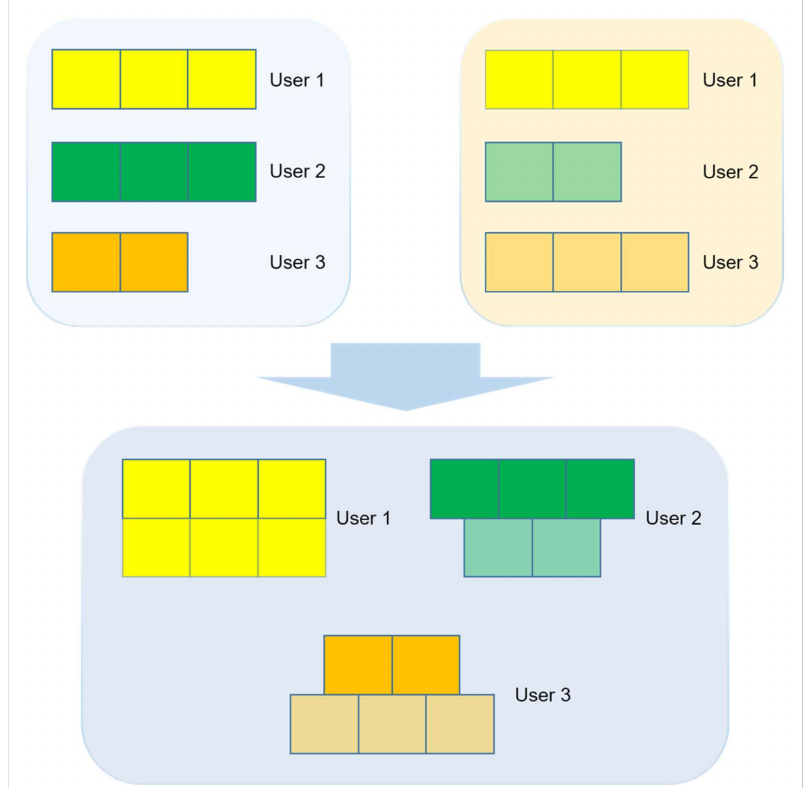
Figure 5. Corresponding scenario for Construction